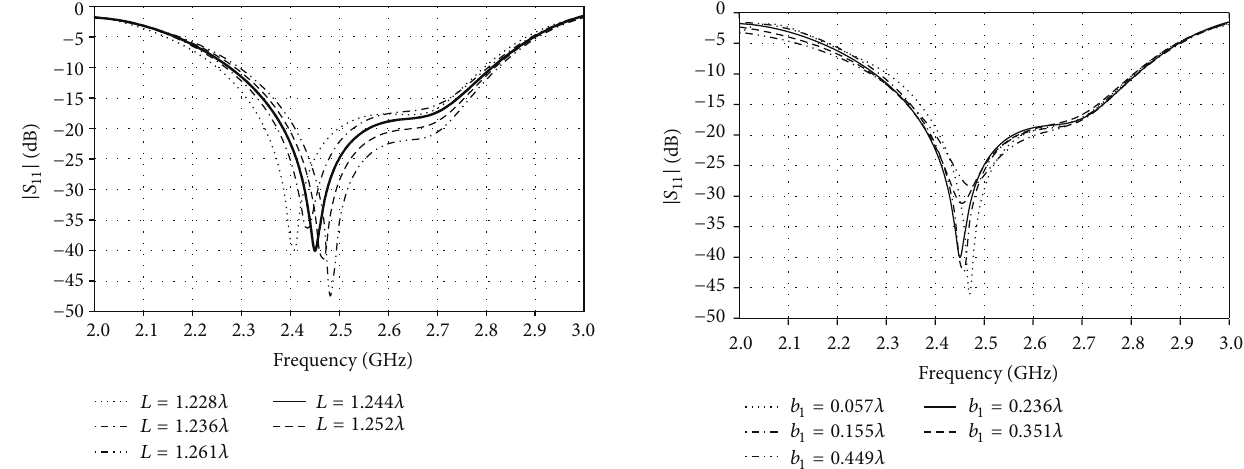
Figure 8: Simulated |𝑆 11 | for various waveguide lengths ( 𝐿 ).